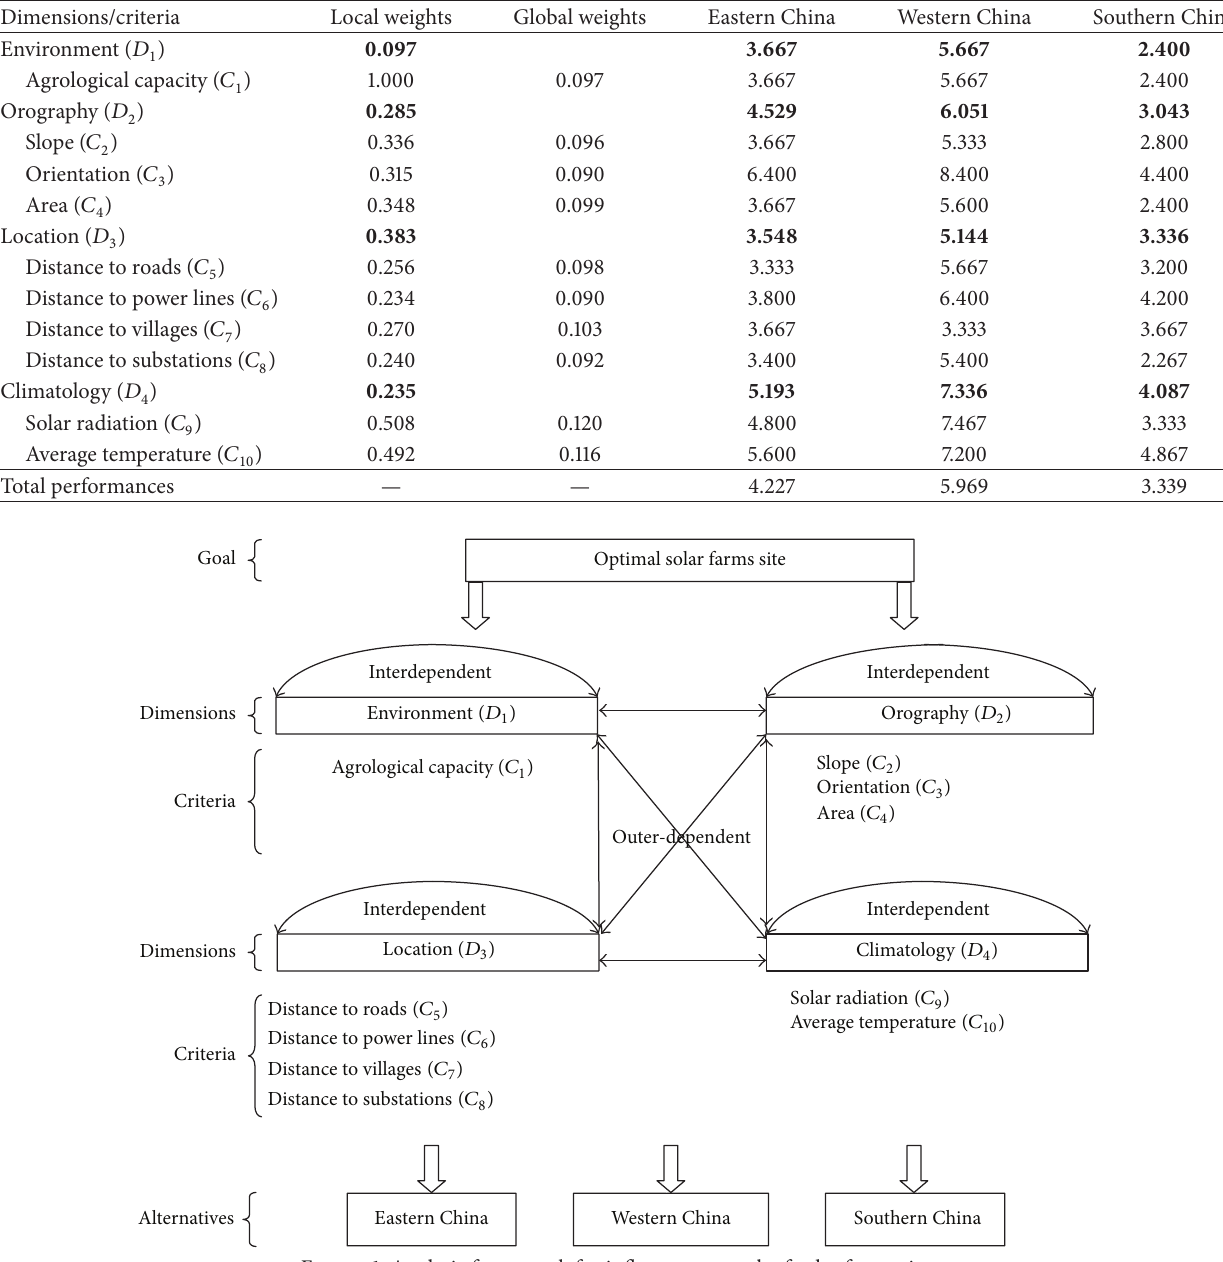
Figure 1: Analytic framework for influence network of solar farms